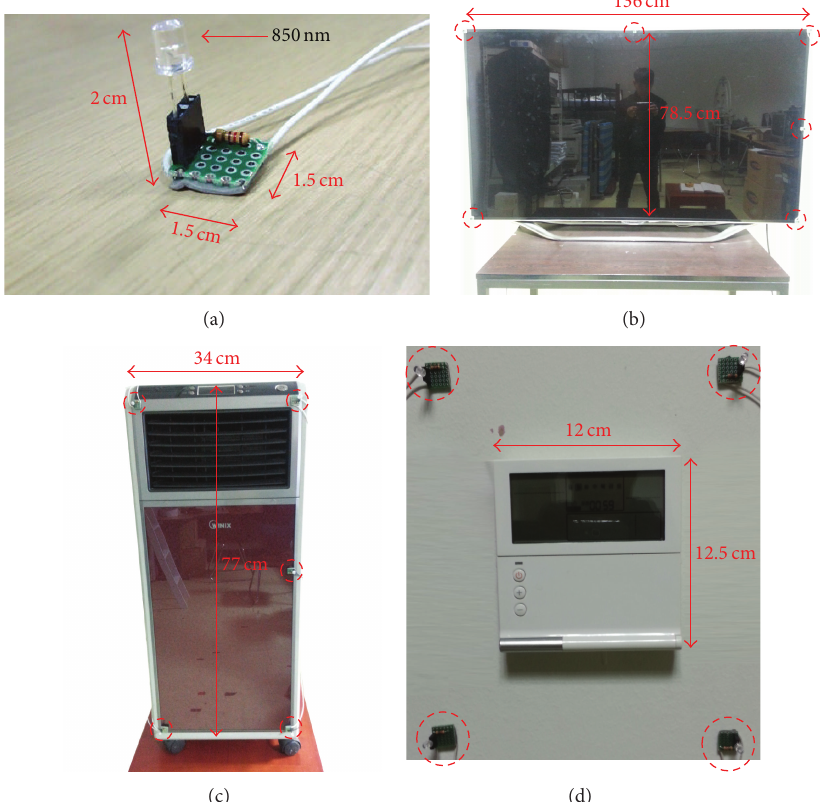
Figure 9: (a) An NIR LED. Attachment of NIR LEDs on home appliances such as (b) a 60-inch television (six NIR LEDs), (c) a heater (fiveNIR LEDs), and (d) an air conditioner switch (fourNIR LEDs). Note that the dotted circles indicate the NIR LEDs.